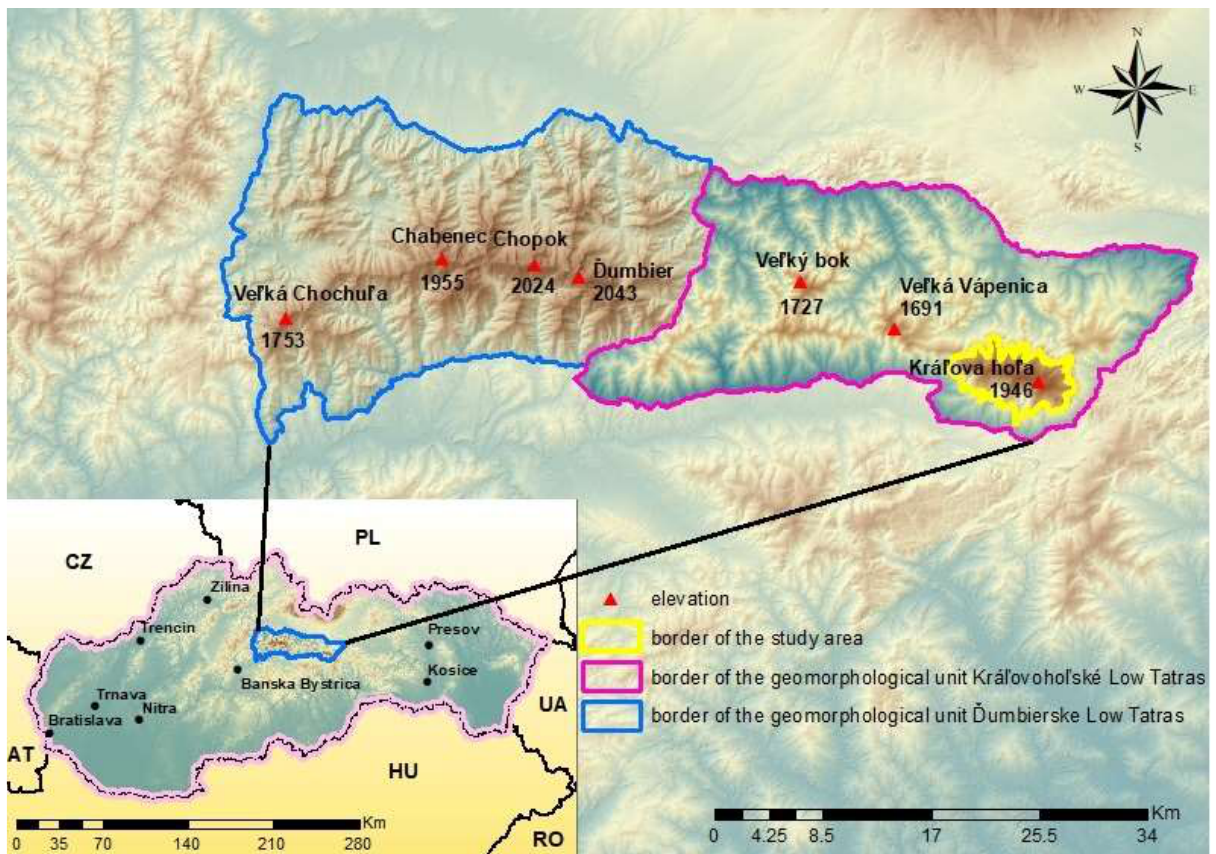
Figure 1 . The location of the studied area. Source DEM: The Geodesy, Cartography and Cadastre Authority of the Slovak Republic.